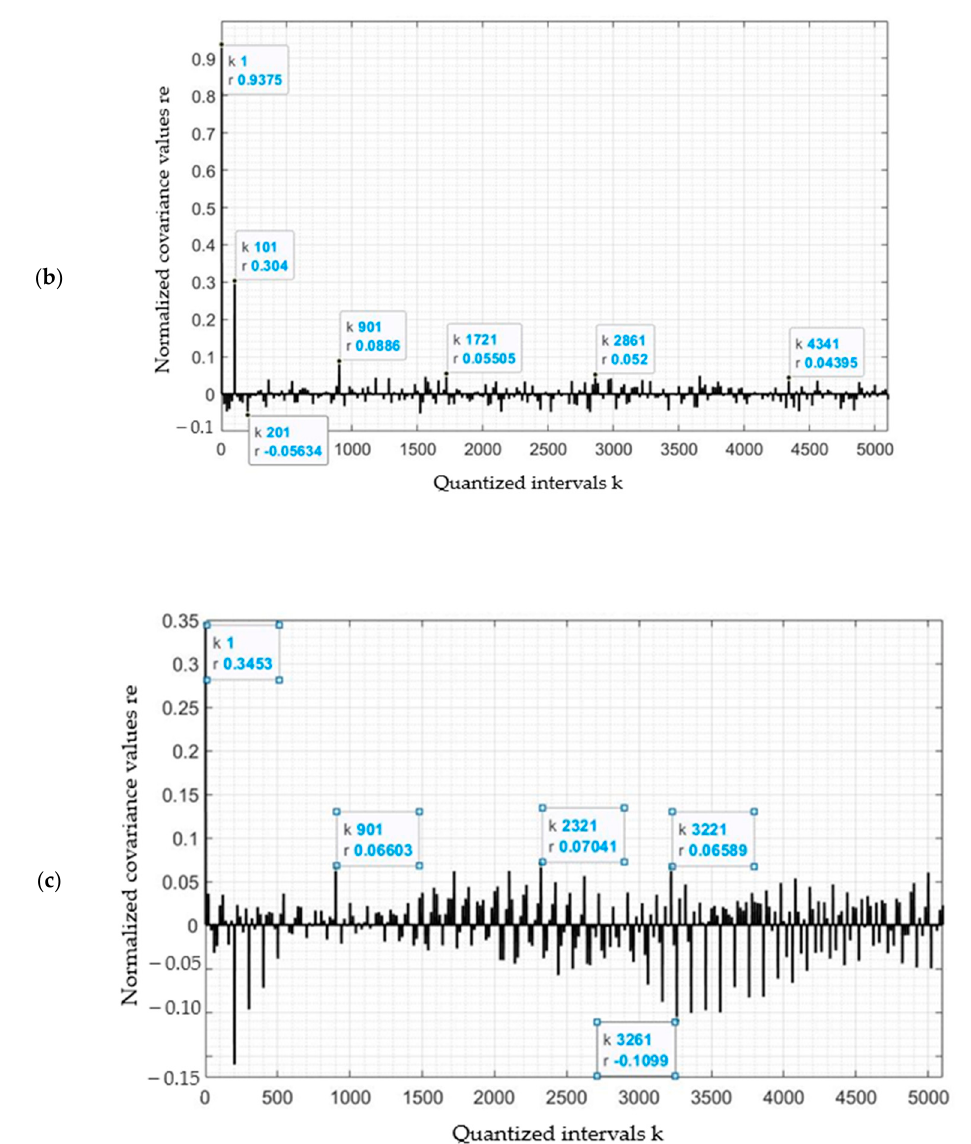
Figure 7. Covariance between pixel vectors: ( a ) kfr12– H. sosnowskyi plants (shown in red in Figure 5) and other plants (shown in green in Figure 5); ( b ) kfr23—other plants (shown in green in Figure 5) and agricultural land (shown in grey in Figure 5); ( c ) kfr13— H. sosnowskyi plants (shown in red in Figure 5) and agricultural land (shown in grey in Figure 5). The covariance values for the auto-covariance function ( r ) for H. sosnowskyi